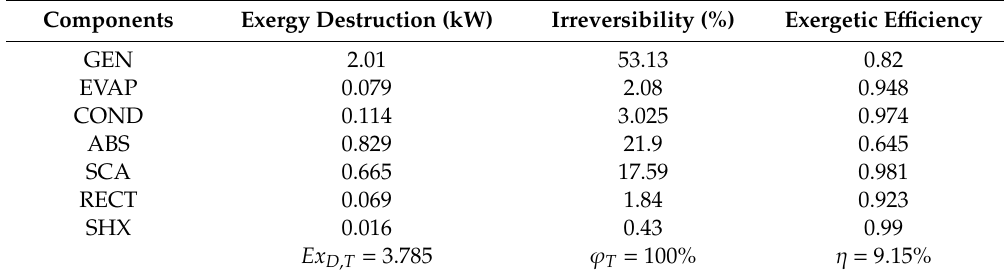
Table 5. Calculated exergetic information of each component at nominal design